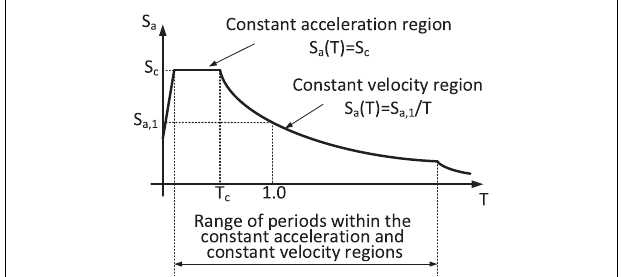
FIGURE 2 | Psuedo-acceleration response spectrum adopted in the study